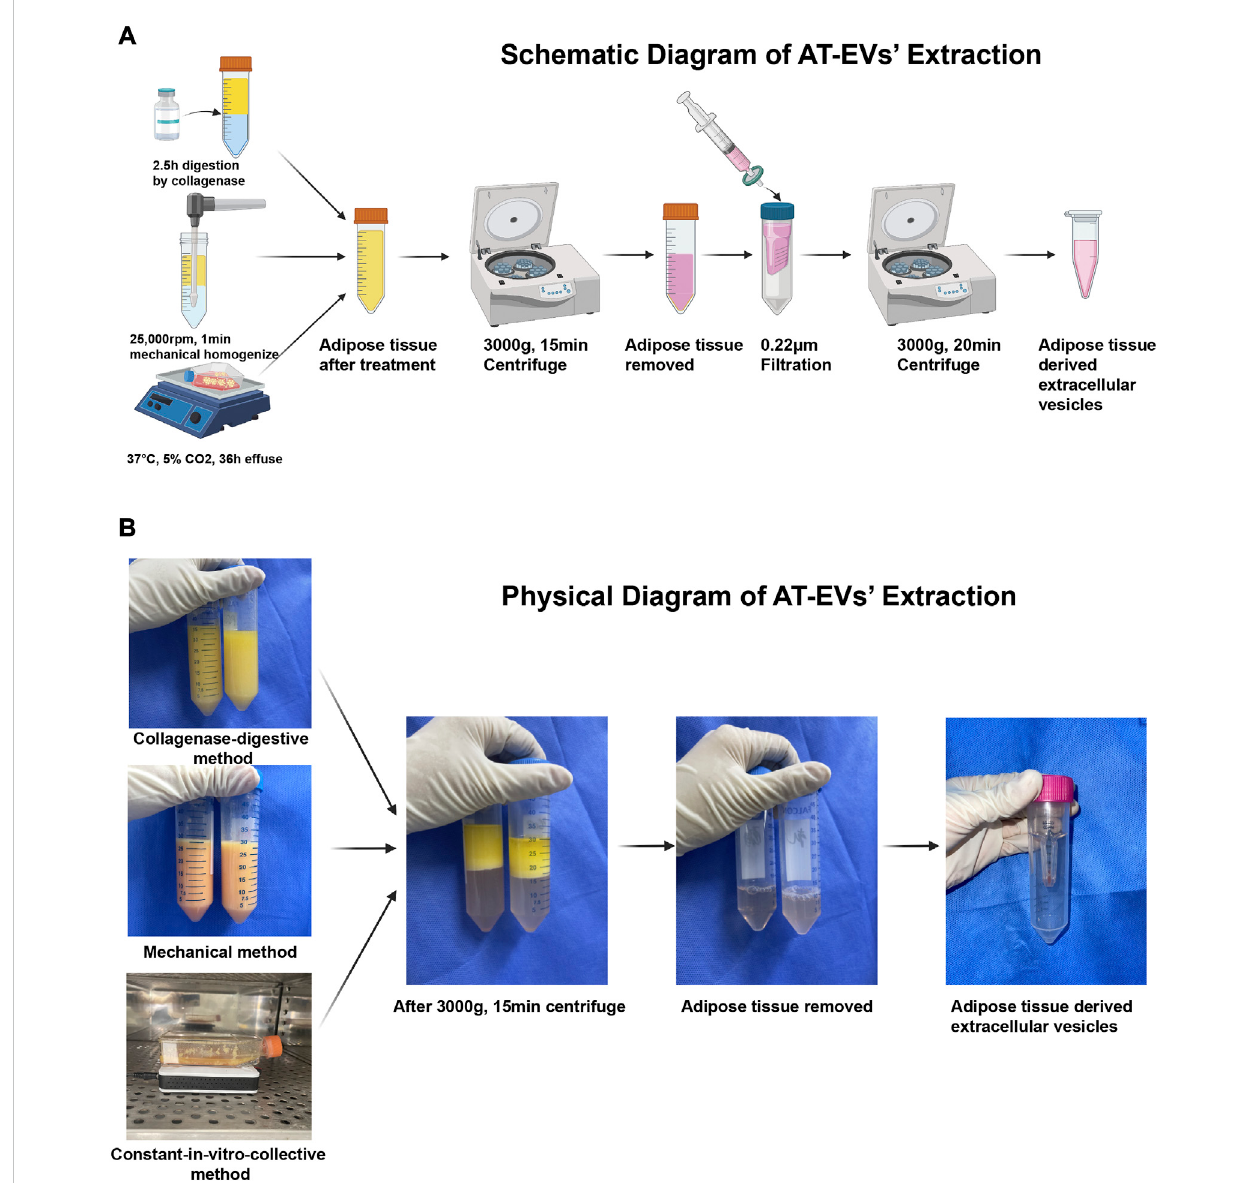
FIGURE 1 Isolation of adipose tissue-derived extracellular vesicles (AT-EVs) (A) Schematic diagram of the major steps involved in the extraction of AT-EVs (B) Physical diagram of the major steps involved in the extraction of AT-EVs.